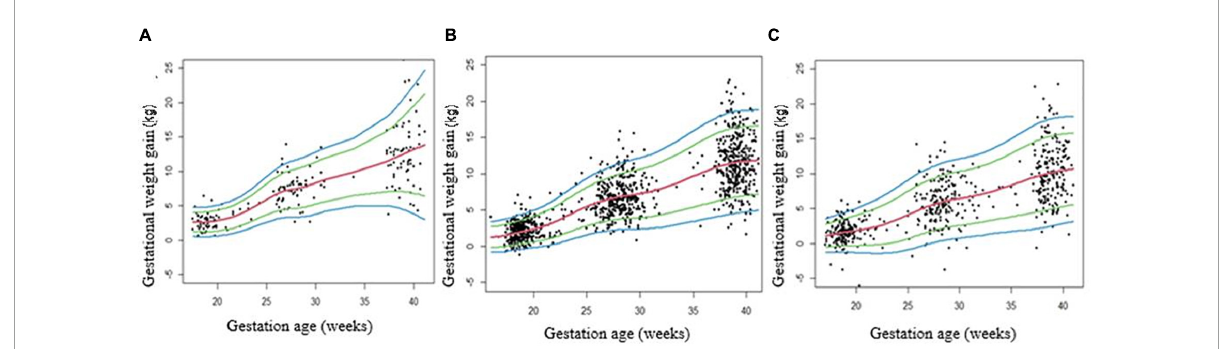
FIGURE3 Gestational weight gain (GWG) centile curves for underweight (A) , normal weight (B) and overweight/obese (C) pregnancies. Centile curves were generated for GWG using the GAMLSS. A: Underweight (BMI < 18.5), B: Normal (BMI ≥ 18.5 and < 25), and C: Overweight/obese (BMI ≥